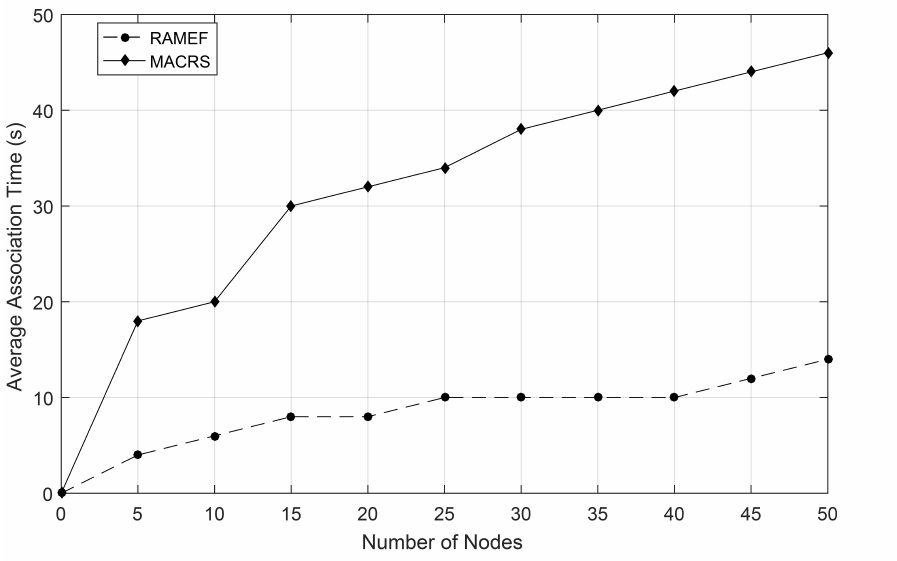
Figure 12. Average association time for a variable number of